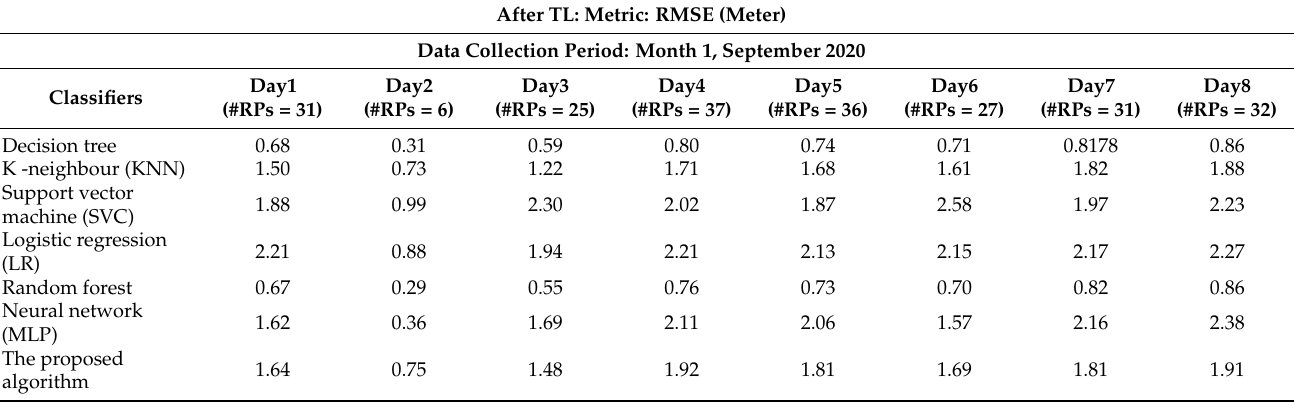
Table 7. Models vehicle’s indoor parking lots of CSI-based fingerprints of various datasets with different temporal